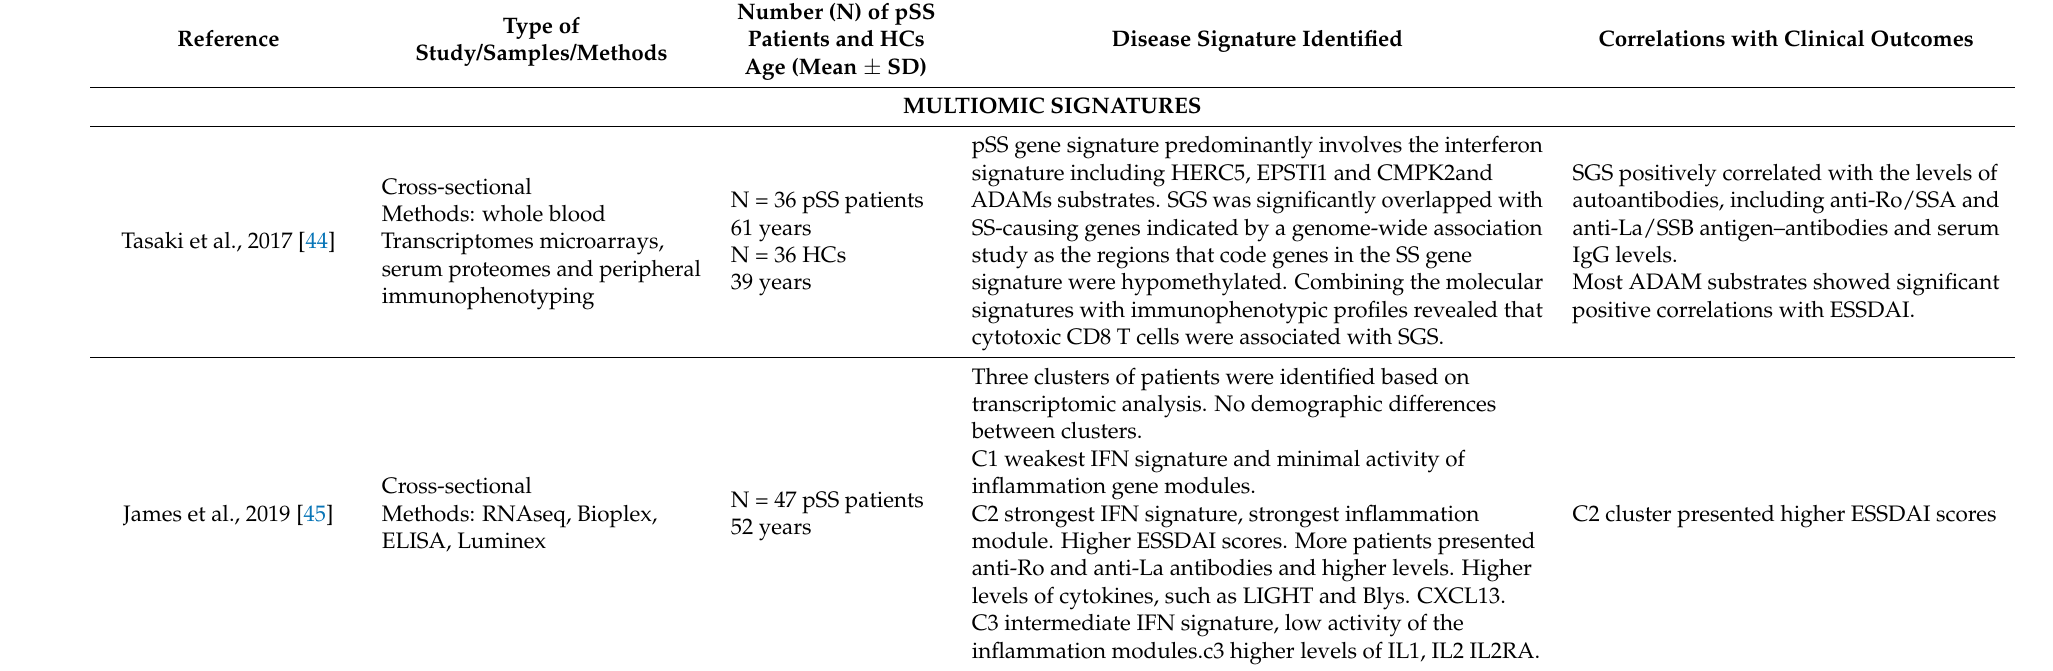
Table 4. Examples of studies investigating potential Sjögren’s Syndrome biomarkers using multi-omic